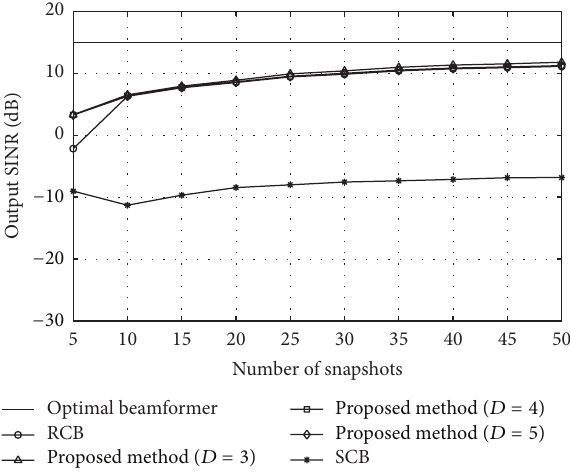
Figure 1: Output SINR versus the number of